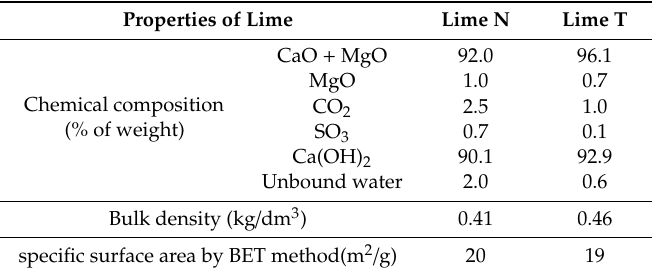
Table 2. Characteristics of hydrated lime N and lime T used in the research.